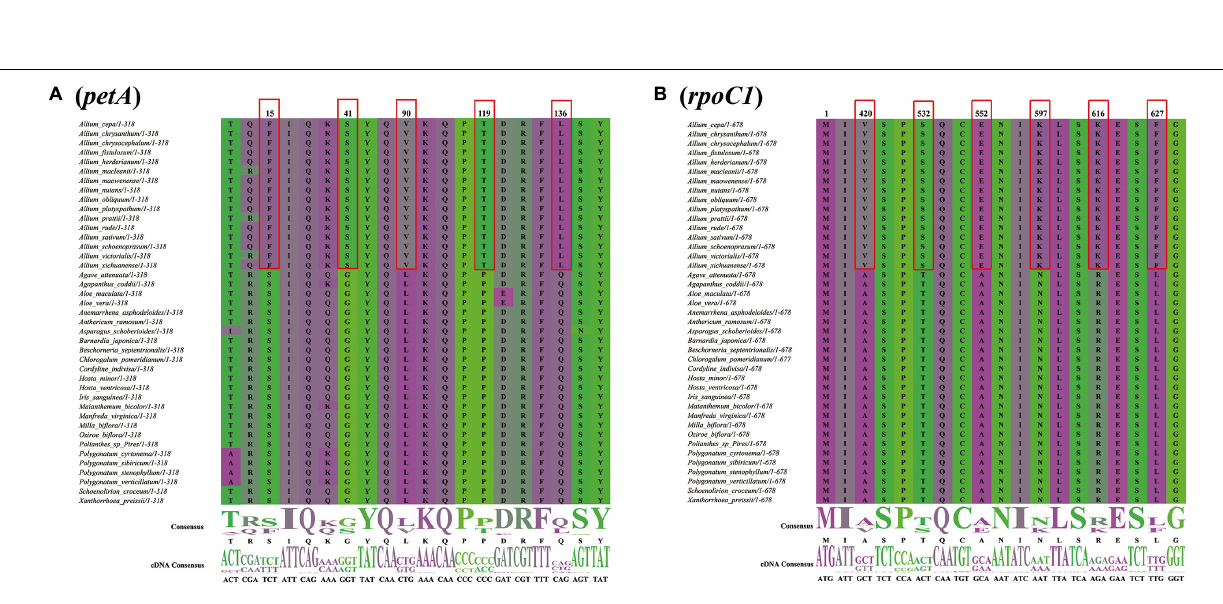
Frontiers in Plant Science |